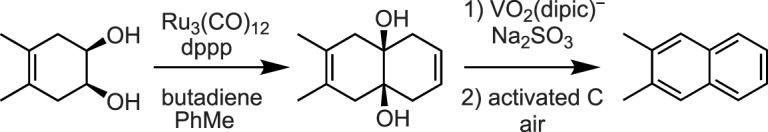
DODH applied in a multi-step organic synthesis sequence.